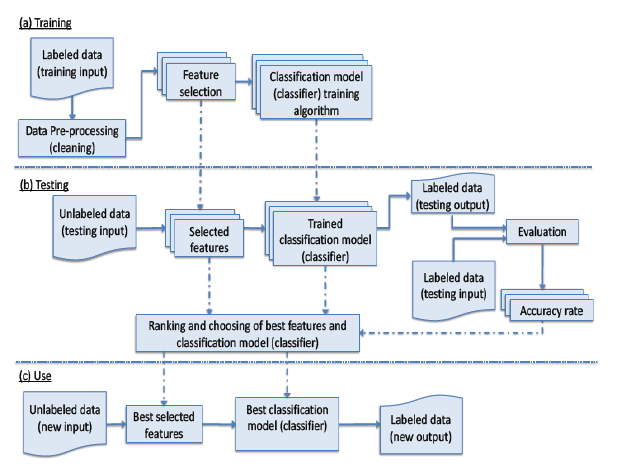
Figure 1. Machine learning process for